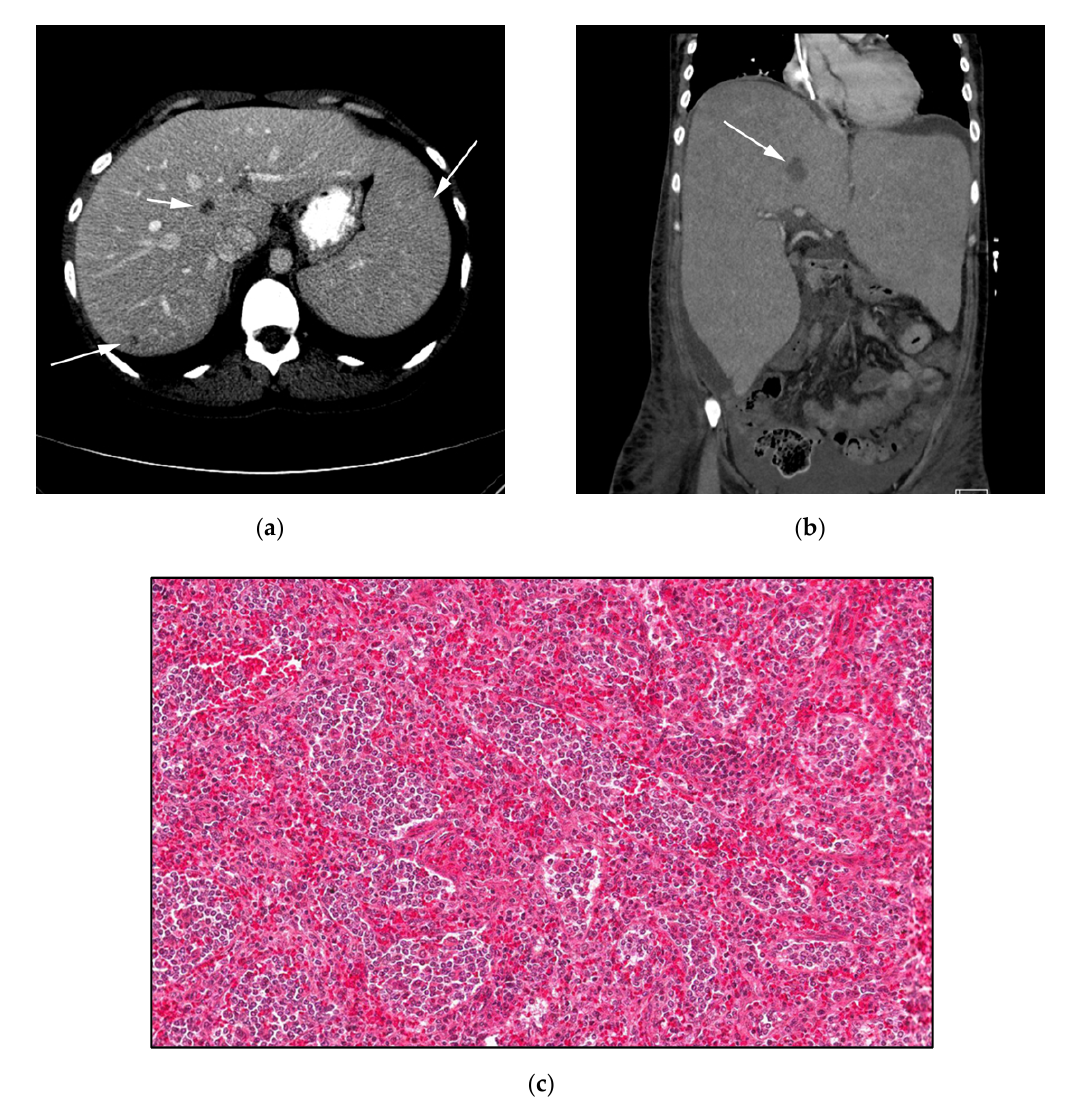
Figure 5. A 31-year-old woman with known history of hepatosplenic gamma delta T-cell lymphoma ( γδ HST ). ( a ) Axial CECT shows splenomegaly and two small indeterminate focal hepatic lesions (white arrows). Patient had biopsy-proven γδ HSTL after splenectomy. ( b ) Coronal CECT obtained three years later shows marked increased size of liver reaching up to 28 cm in craniocaudal dimensions. There is also increased size of the previously seen central focal hepatic lesion (white arrow). ( c ) Histologic section shows moderate-sized neoplastic cells with condensed nuclei, small nucleoli and a pale cytoplasmic rim. The neoplastic cells are infiltrating the red pulp of the spleen but show a striking predilection to the splenic sinusoids. In contrast, γδ HST spares the portal triads and the splenic white pulp. (Original magnification 400 ×, H&E stain)